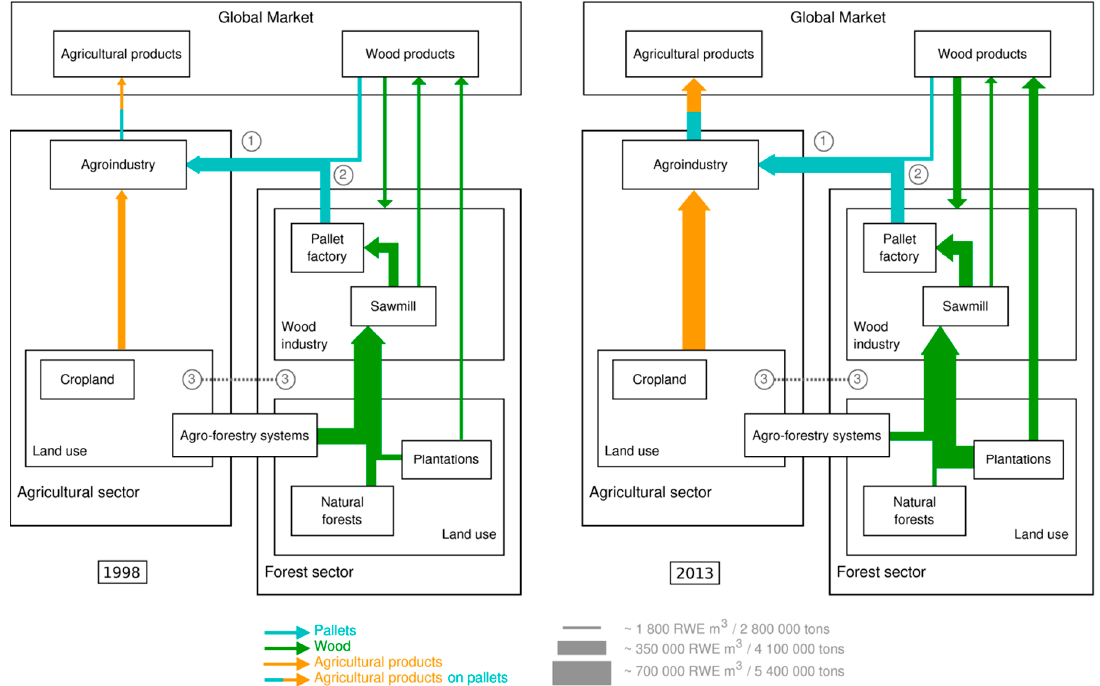
Figure 1. Main material flows between the forestry and agricultural sectors of Costa Rica, and the international market, resulting from the use of wood pallets to export the five main agricultural products exported on wood pallets over the past three decades (bananas, pineapples, melons, palm oil and cassava). The color of arrows represents the nature of the corresponding flows, while their width represents the size of the flows for the years 1998 and 2013. Flows of pallets are expressed in number of items ( blue ), flows of wood in roundwood equivalent cubic meters ( green ), and flows of agricultural products (on pallets or not) in tons ( orange ). Numbers in grey refer to the three questions addressed in this study.